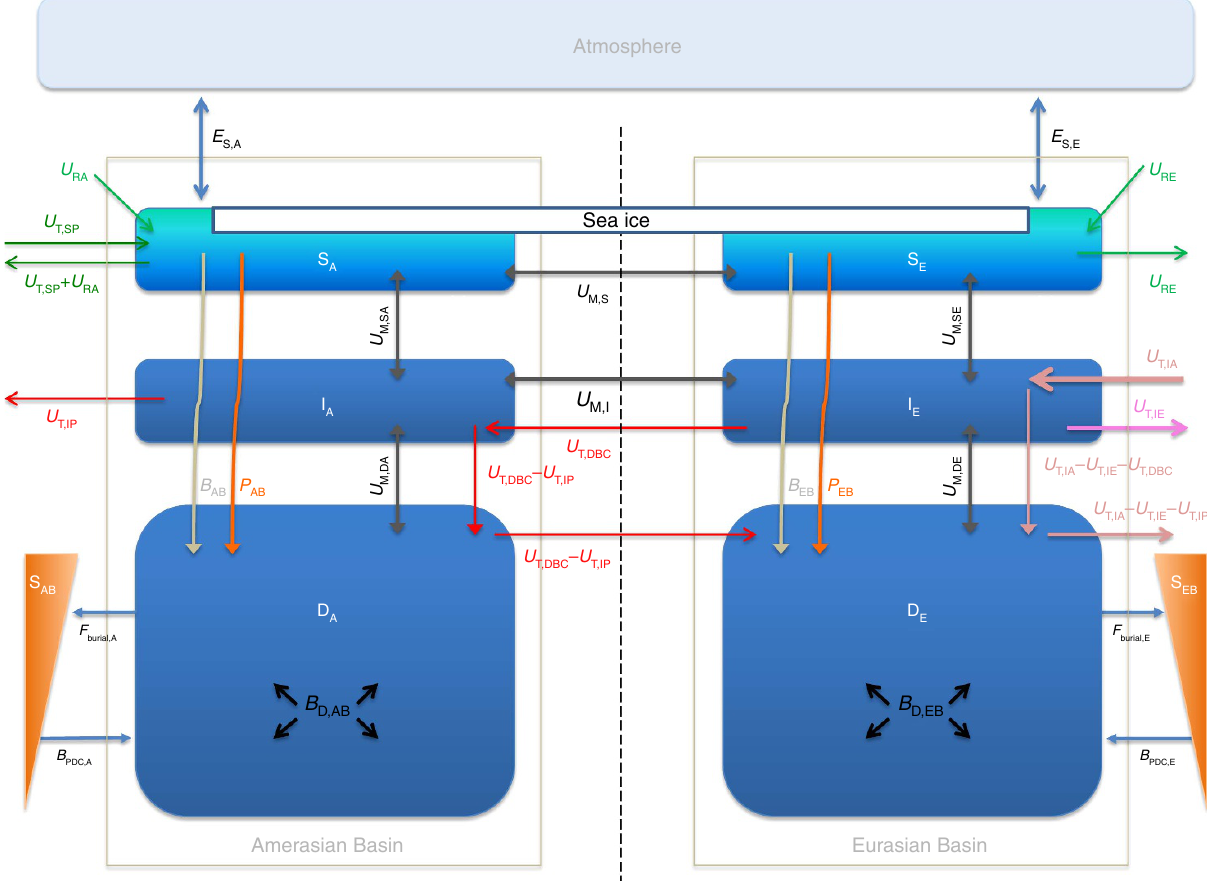
Figure 2 | The box model for the carbonate system of the Arctic Ocean. The model divides the Arctic Ocean into a collection of six boxes, that is, surface Amerasian Basin (S A ), intermediate Amerasian Basin (I A ), deep Amerasian Basin (D A ), surface Eurasian Basin (S E ), intermediate Eurasian Basin (I E ), deep Eurasian Basin (D E ), as well as an atmospheric box and two sediment reservoirs (S AB and S EB ) connected to the deep water boxes. Water flows between boxes are designated by capital U ’s, the capital E ’s indicate gas exchanges, the B ’s stand for internal fluxes of CaCO 3 and the F ’s are the fluxes of CaCO 3 to the sediments. Subscripts refer to the particular ocean (A and E), the different depth boxes (S, I and D) and the nature of the flux, for example, T for thermohaline, M for mixing, D for dissolution and so on. In addition, DBC stands for deep boundary current and PDC abbreviates previously deposited